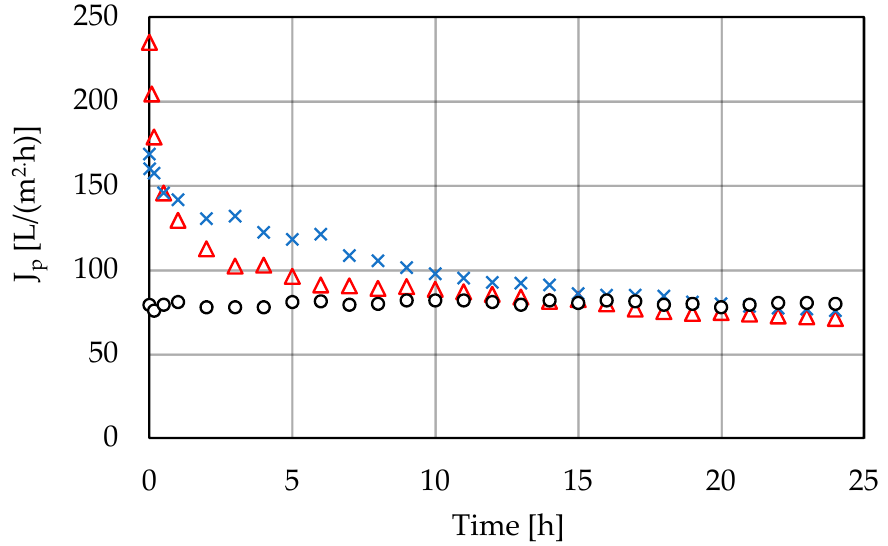
Figure 4. Permeate flux change during the nanofiltration process; PCI NF membrane, T = 25 °C (o, 1.0 MPa; × , 2.0 MPa; ∆ , 3.0 MPa). Points represent the average of five measurements.